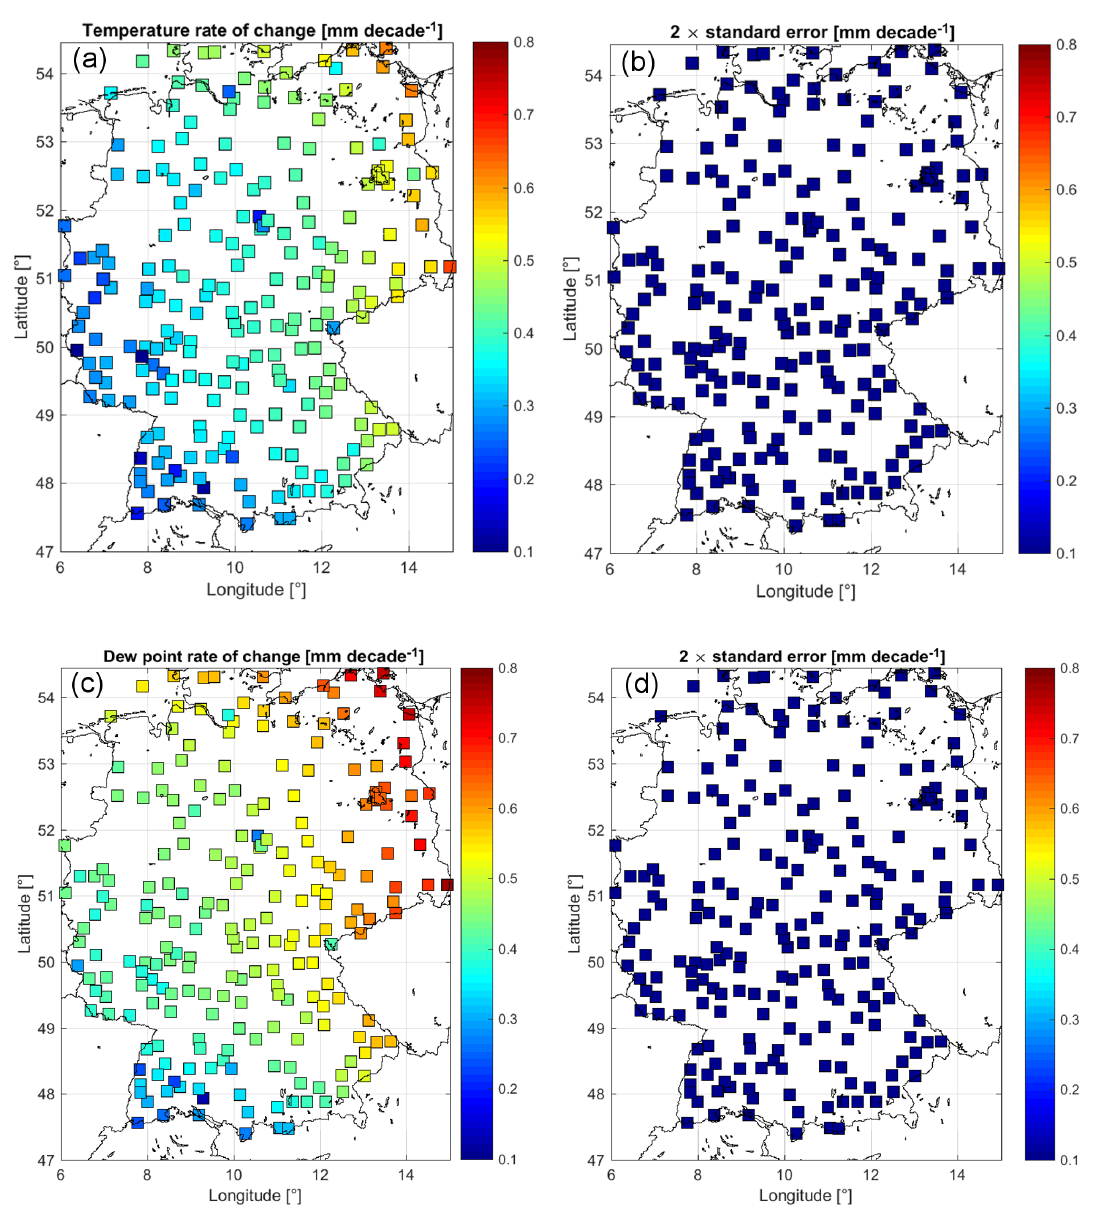
Figure 13. Estimated temperature trends using surface measurements of (a) temperature, (c) dew point temperature, and the corresponding standard error of the estimated slope (b, d)